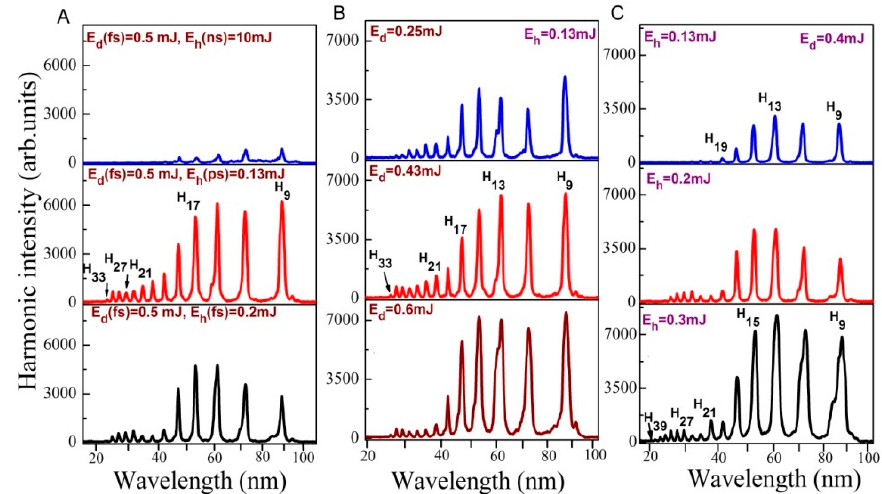
Figure 4. Harmonics spectra from ablated bulk Au at ( A ) different energies of ns heating pulses, ( B ) different energies of fs driving pulses, and ( C ) different energies of ps heating pulses. ( B ) di ff erent energies of fs driving pulses, and ( C ) di ff erent energies of ps heating